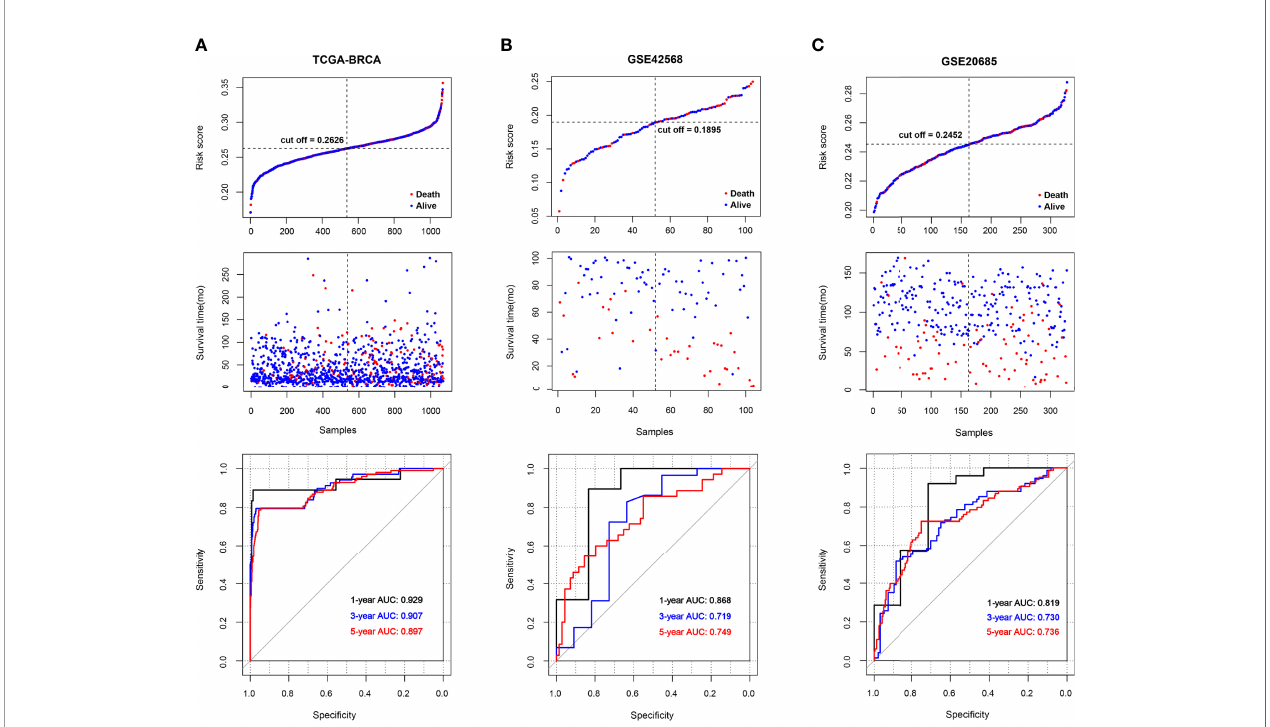
FIGURE 4 | The survival status and ROC curves. (A-C) The survival status for each patient and the time-dependent ROC curve in TCGA (A) , GSE42568 (B) , and GSE20685 (C) .